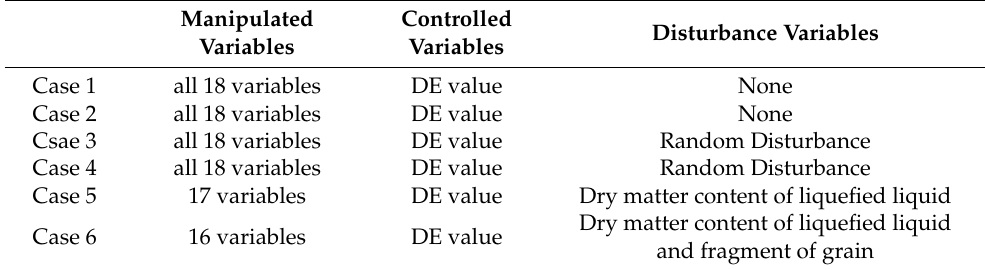
Table 2. List of the manipulated variables, controlled variables and disturbance variables.